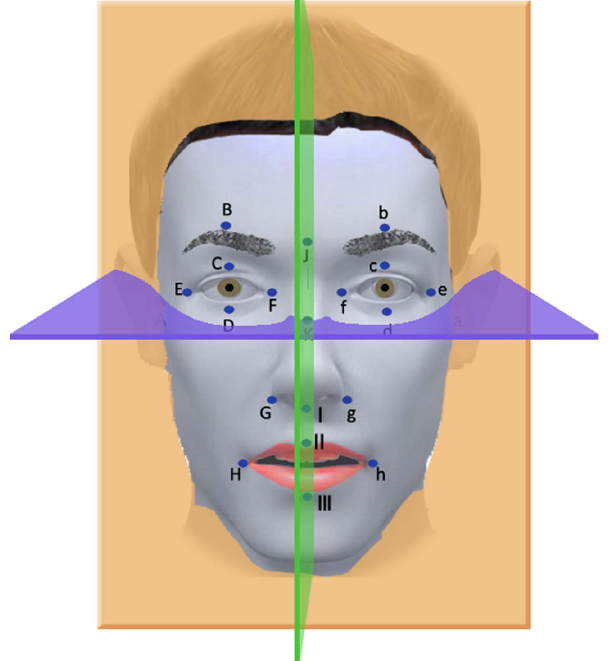
Figure 3. Reference planes.